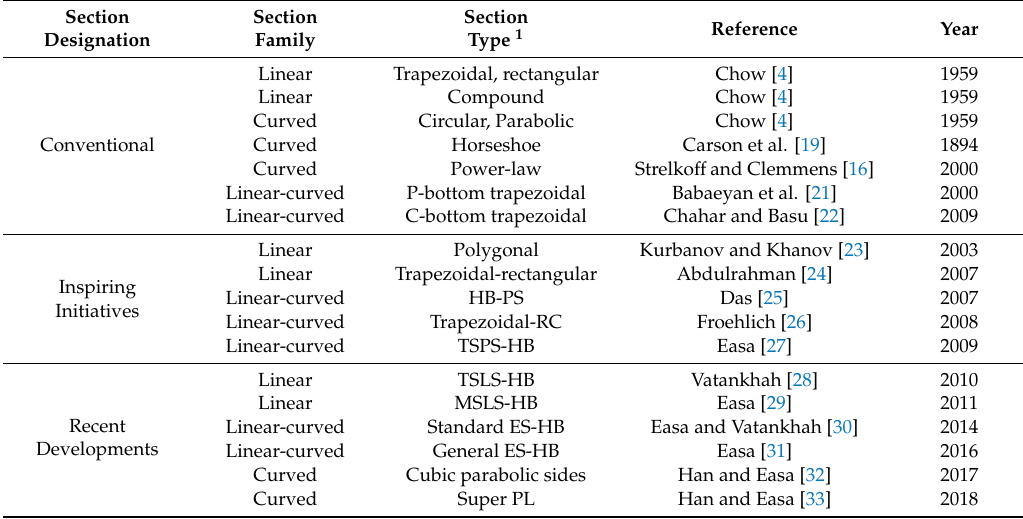
Table 1. Historical developments of the main shapes of open channel